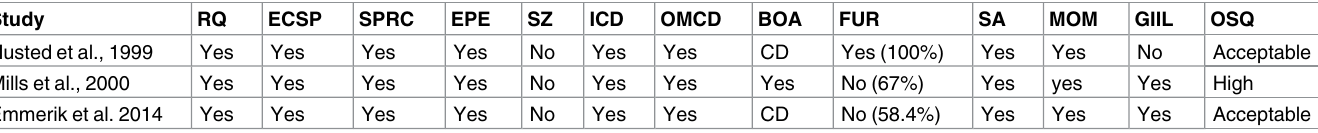
Table 2. Study quality assessmentfor observational studies.